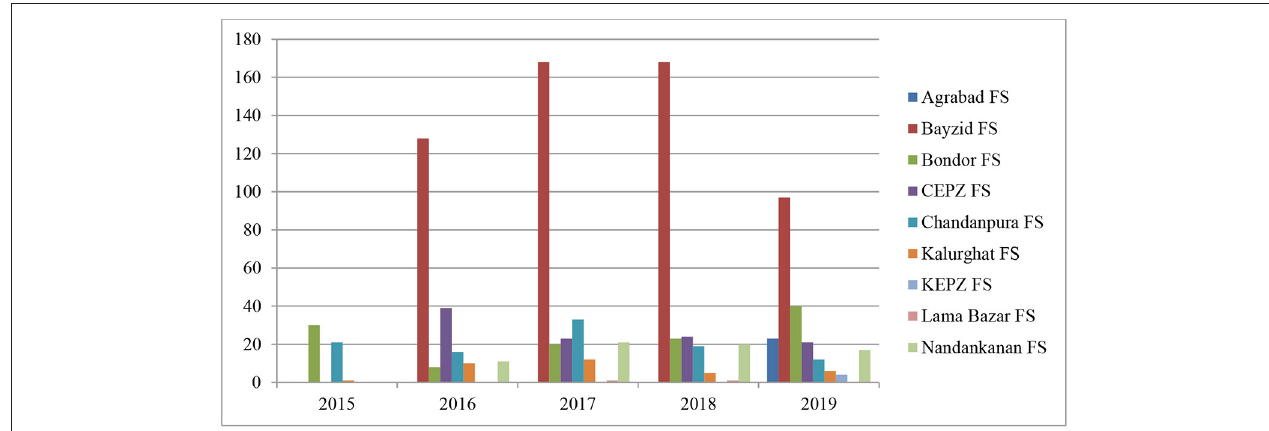
FIGURE 2 | Comparative scenario of the total number of fire incidents in each year for the nine fire